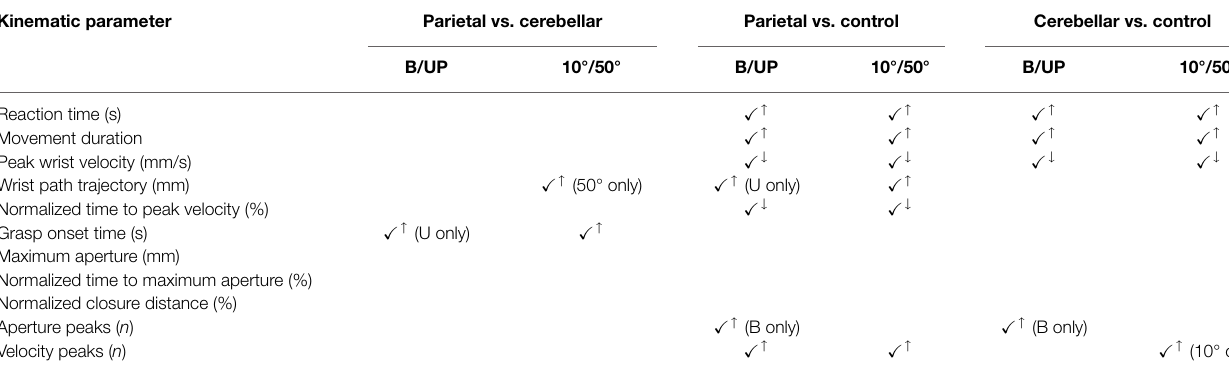
TABLE 3 | Summary of significant interactions between groups and conditions . Kinematic parameter